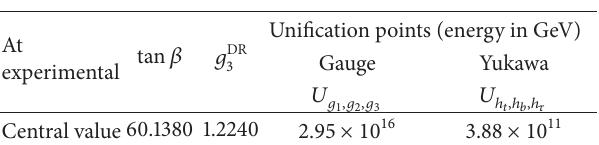
Table 5: Exact unification points for gauge couplings and